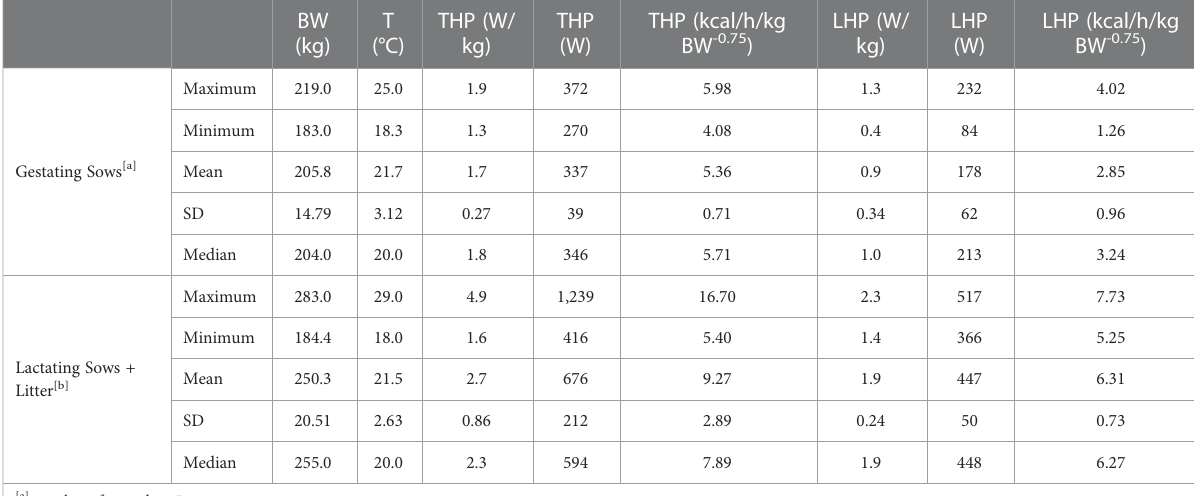
TABLE 3 Summary statistics for heat production from gestating sows and lactating sow plus